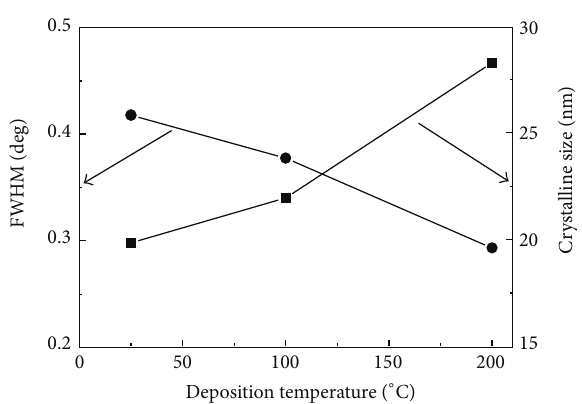
Figure 2: FWHM value and crystalline size of the GZO thin films as a function of substrate